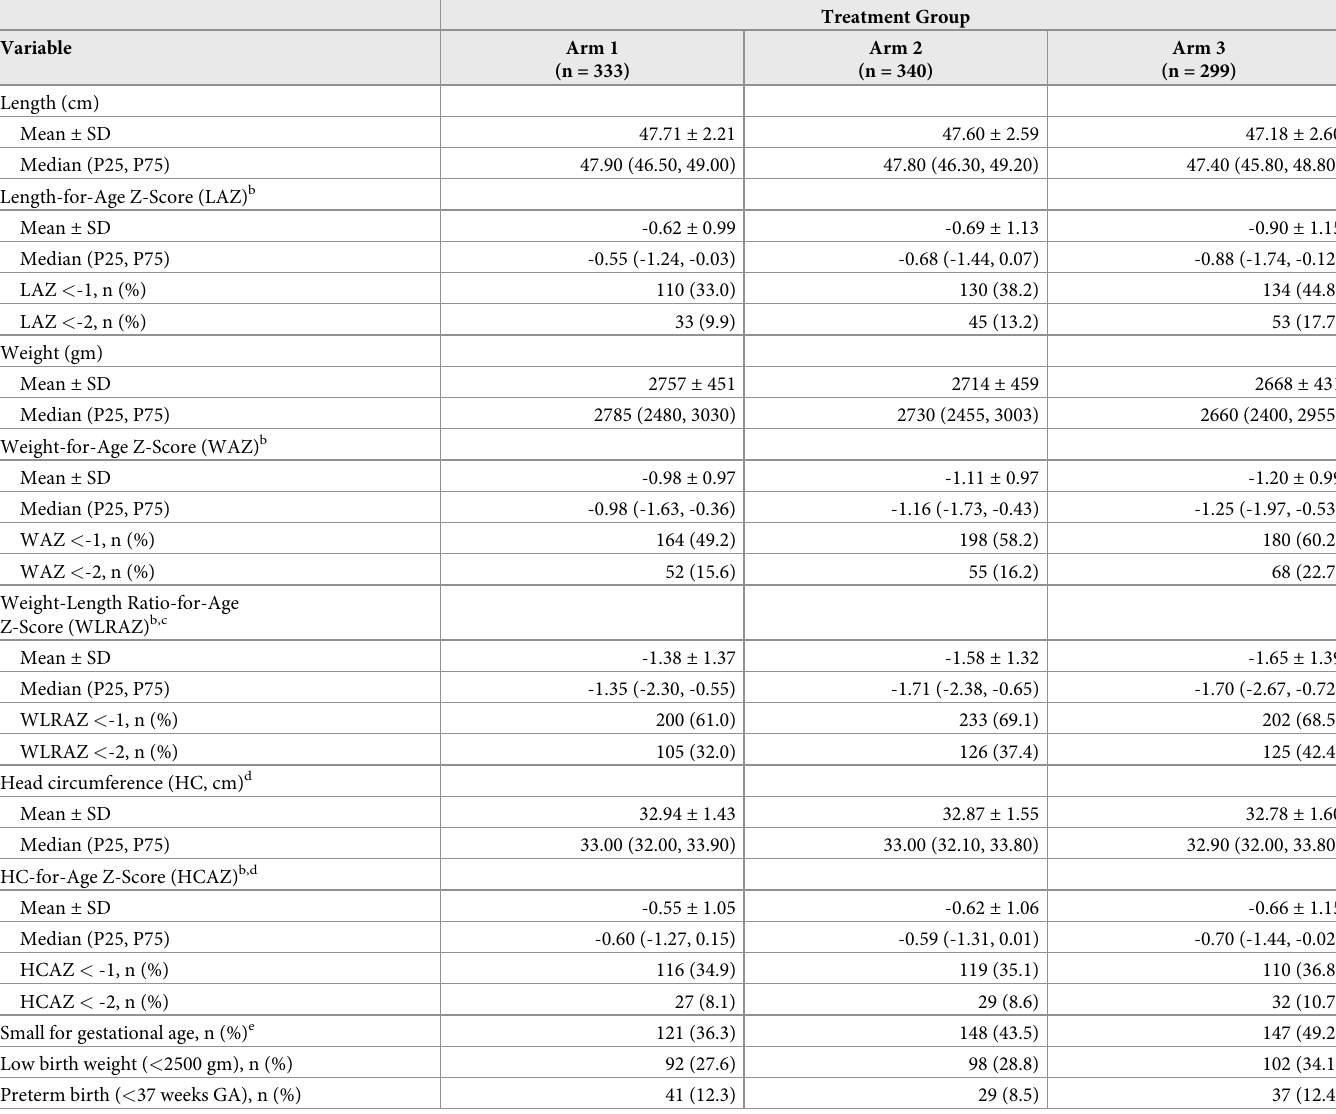
Table 2. Women First Maternal Preconception Nutrition Trial in South Asia. Growth outcomes by treatment arm among all livebirths with gestational age at birth a available and length measurements within 48 hours after